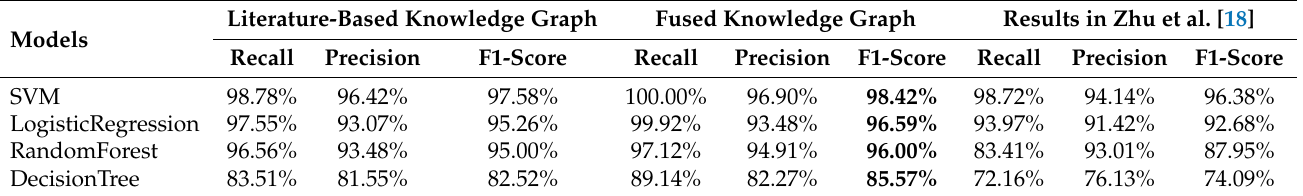
Table 3. Experimental results of machine learning methods using different knowledge graph.